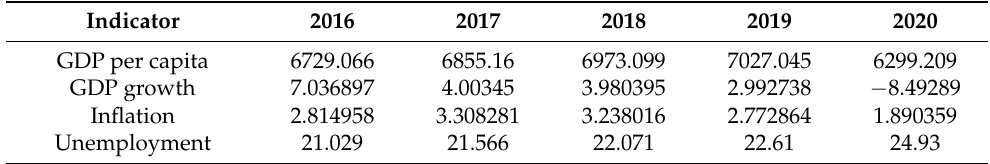
Table 1. Macroeconomic indicators